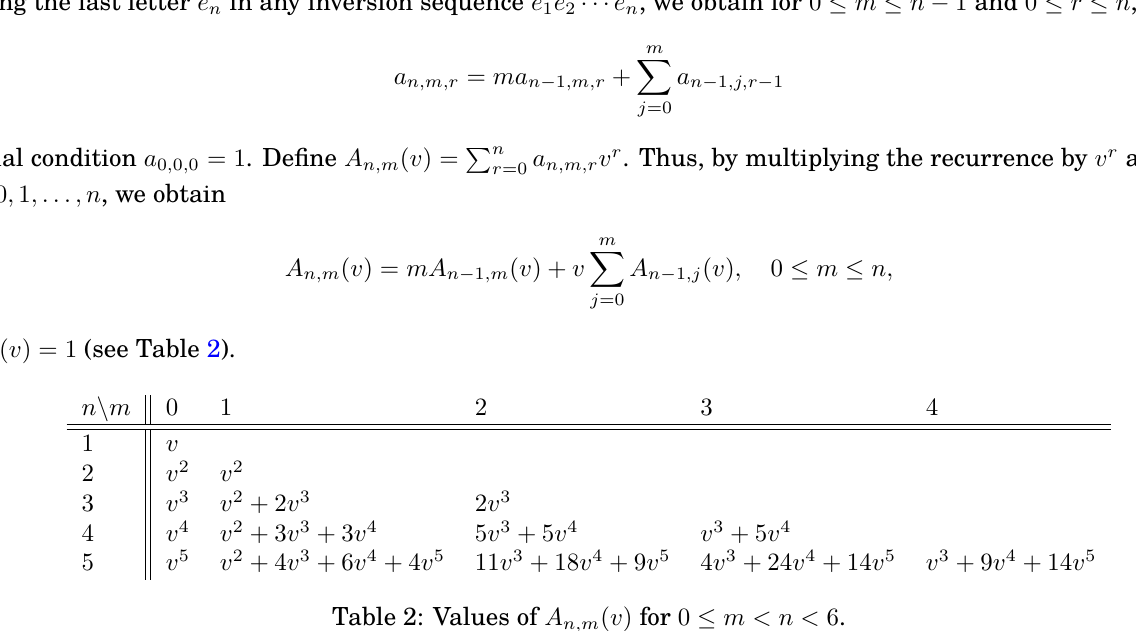
Table 2: Values of A n,m ( v ) for 0 ≤ m < n < 6